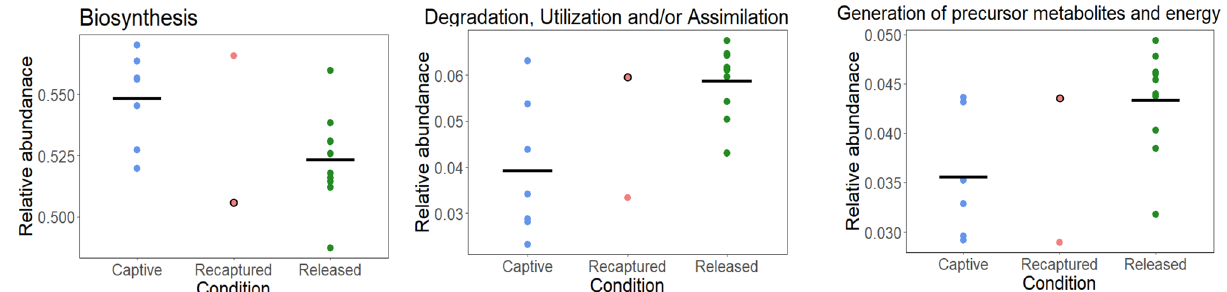
Figure 6. Differences in relative abundance of gut microbiota functional pathways between conditions. Samples with dark border represent the first sample collected from the individual back to